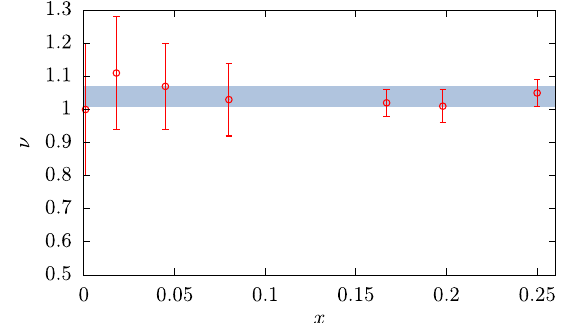
FIG. 4. Critical exponent ν as a function of the concentration x . The shaded area corresponds to their average value over all concentrations. The individual estimates come from an extended finite-size scaling analysis of the two-point correlation length; an example is shown in Fig. 1(a). All estimates agree within error bars, meaning that the critical exponent ν might be independent of the concentration x . This hints towards the possibility of a common universality